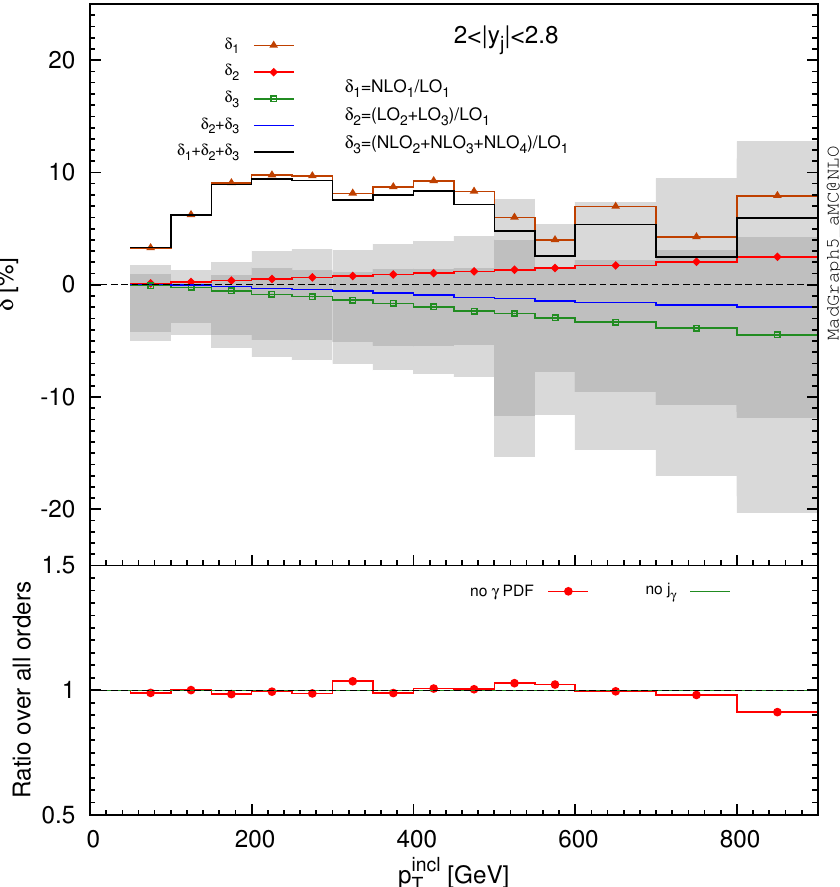
Figure 9 . Single-inclusive transverse momentum, for 2 < j y j (cid:20) 2 :